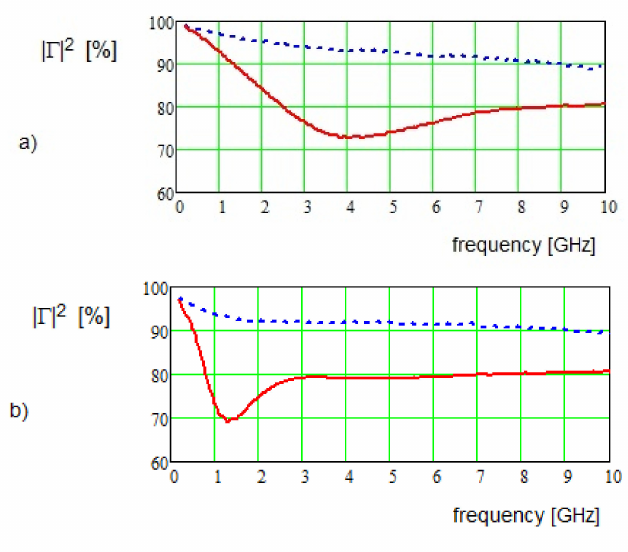
Figure 5. Reflection coefficients of power density of the absorber backed with the metal layer with thickness: ( a ) 2 mm, ( b ) 5 mm; graphite—blue, dotted line; RGO—red,